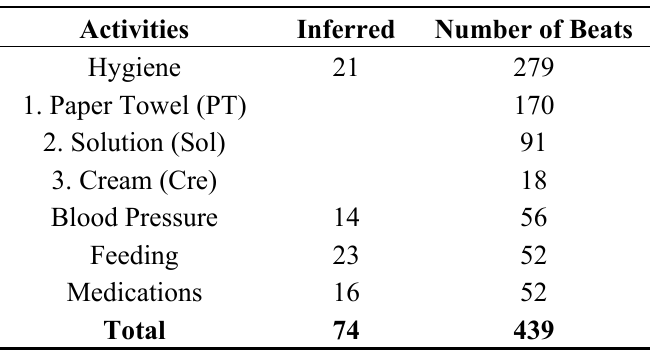
Table 2. Activities inferred and the number of